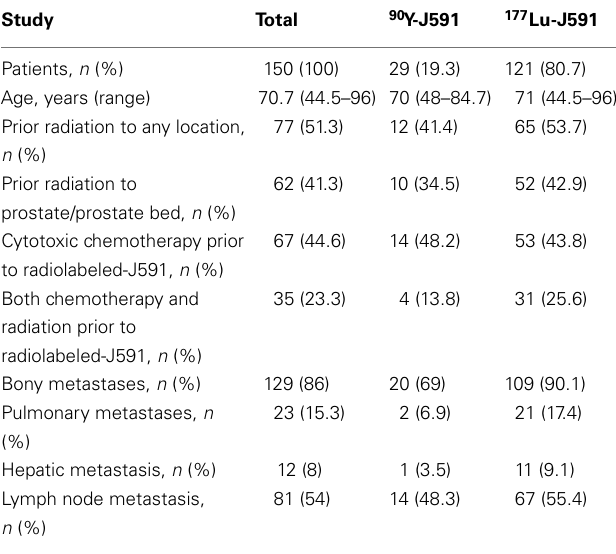
Table 2 | Baseline characteristics.